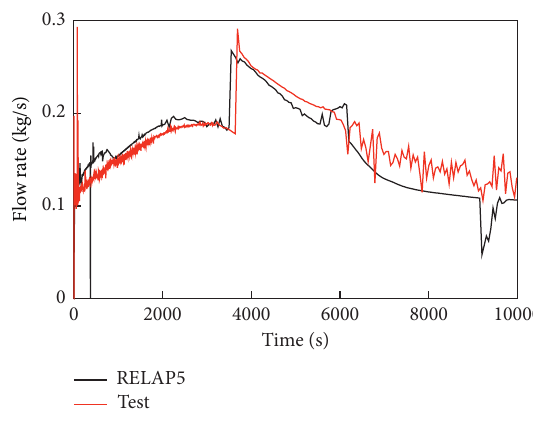
Figure 5: Flow rate of the heat exchanger.